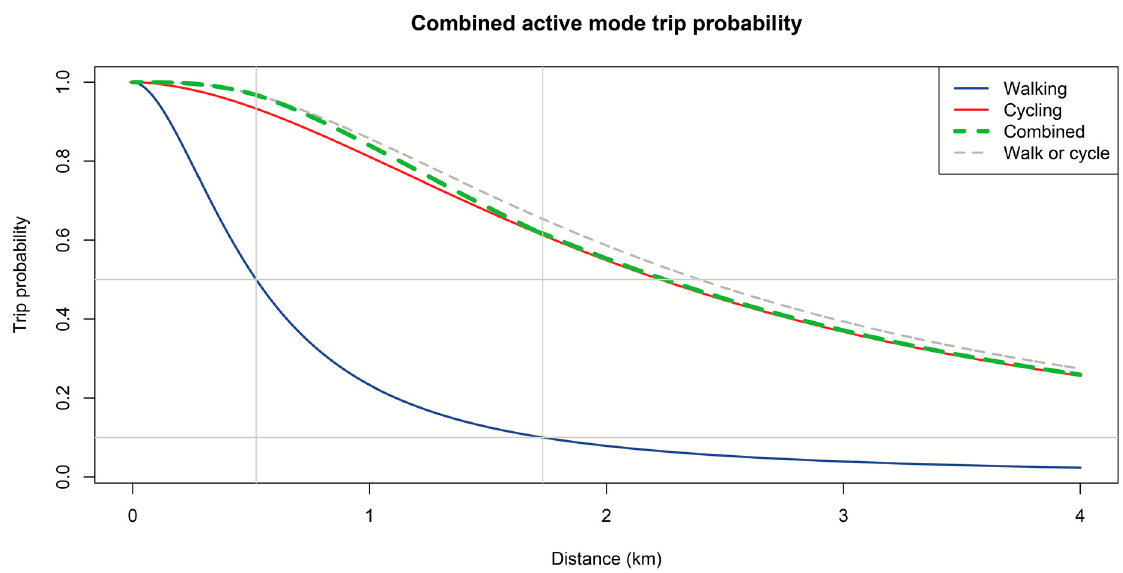
Figure 1. Combined active mode trip probability function for accessibility to